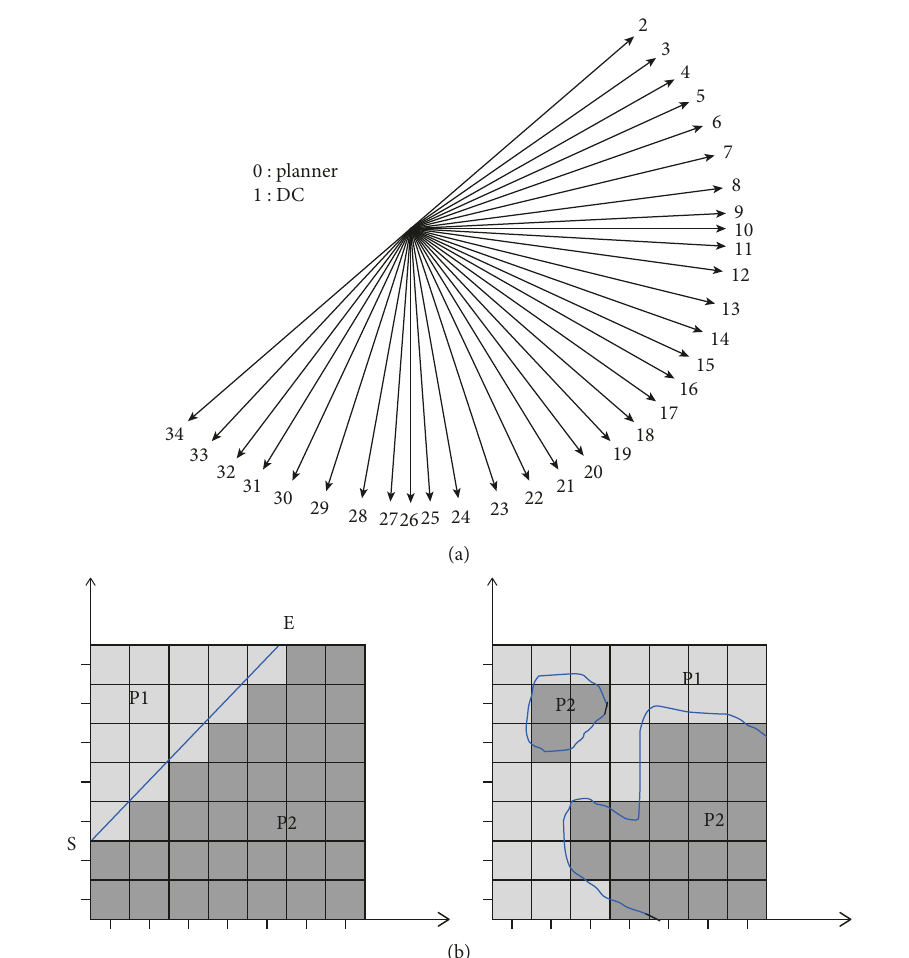
Figure 2: 3D-HEVC depth map intraprediction tools: (a) intra-angular and (b) depth modeling modes: wedgelet (left) and contour